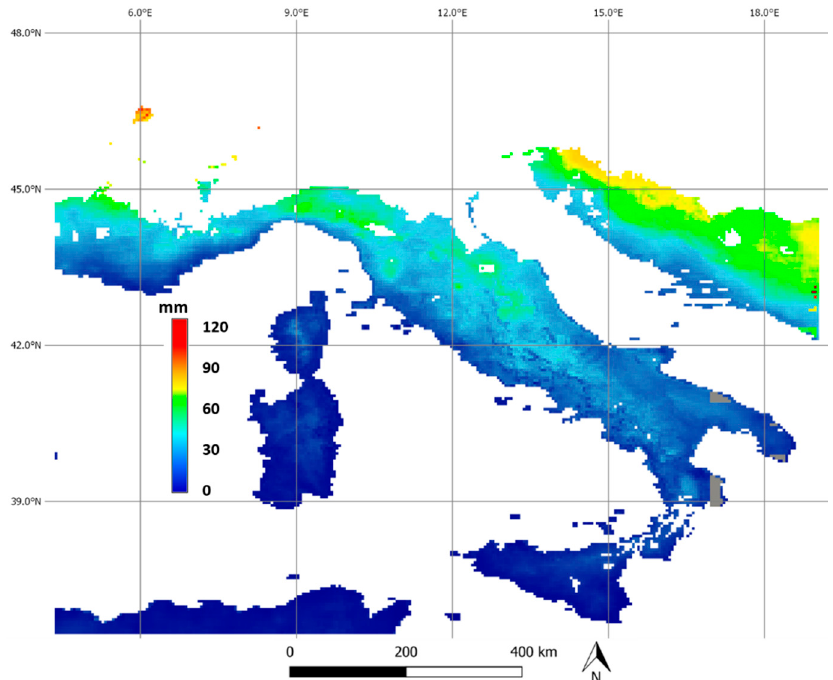
Figure 8. Summer (July and August) precipitation mean values for the only pixels in the clusters R7, R8, and R9, which exhibit the annual minimum in summer.